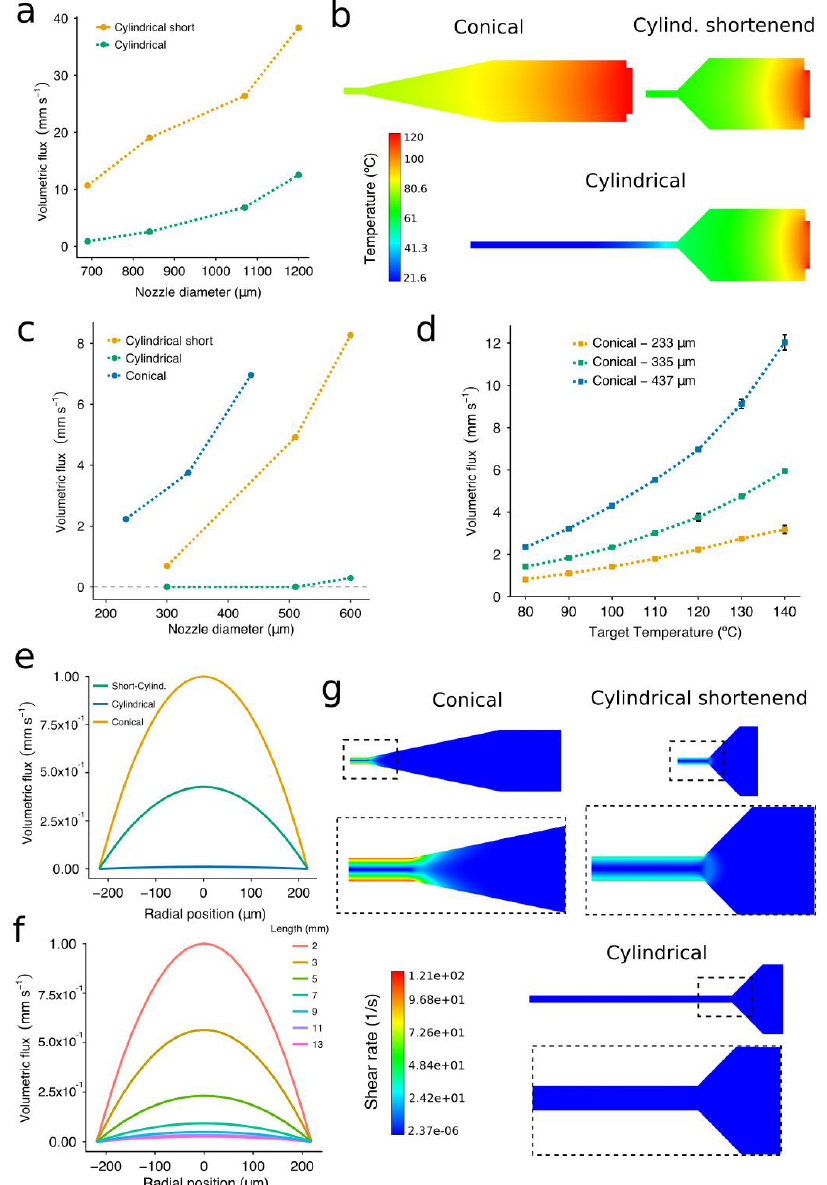
Figure 4. Experimental and simulated volumetric fluxes from the computational fluid dynamics (CFD) simulations using nozzles of different geometries and sizes. ( a ) The relationship between volumetric flux and needle length for cylindrical nozzles at a target temperature of 120 °C. ( b ) Temperature contour plots from the CFD simulation using conical, cylindrical, and shortened